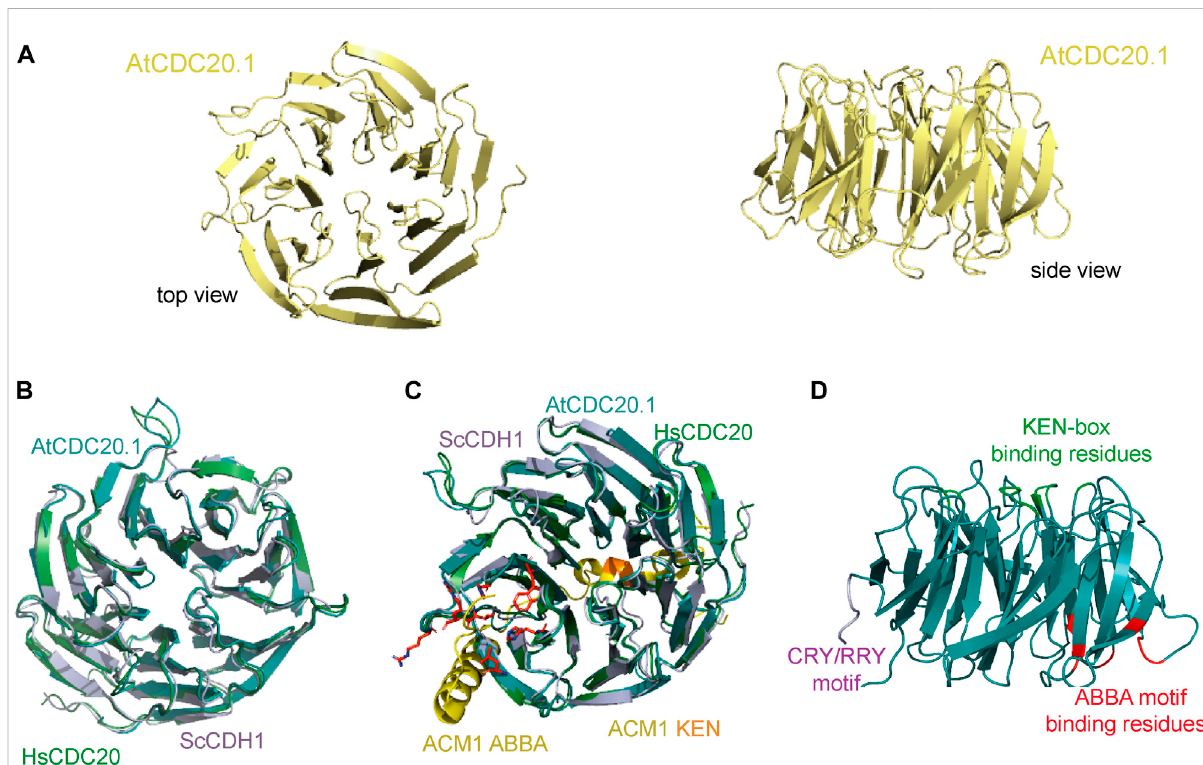
FIGURE 4 Predicted AtCDC20.1 WD40 3D structure. (A) Two views of the AtCDC20.1 3D structure model in a ribbon representation. The model was generated by comparative modelling using Phyre2 (Kelley et al., 2015). (B) Structure superposition of AtCDC20.1 WD40 structure model (cyan) with humanCDC20WD40(green,PDBID4GGC),andCDH1WD40frombuddingyeast(purple,PDBID4BH6)revealsahigh3Dstructureconservationof CDC20from various species andyeastCDH1. (C) Structure superpositionofCDH1incomplexwithan ACM1 fragment containingtheKEN-box and ABBA motifs (shown in yellow, PDB ID 4BH6) and CDC20 from human (shown in green, PDB ID 4GGC) and the A. thaliana 3D structure model showsthepredictedmodeofinteractionofAtCDC20.1withinteractionpartnersofthisproteinthatcontainthesemotifsandmediateSACsignalling. The AtCDC20.1 residues predicted to bind the ABBA motif are shown in red in stick and ball representation, while those predicted to bind the KEN- box are highlight in orange. (D) . Cartoon illustrating the mapping of the CRY/RRY motif (shown in purple) and a simpli fi ed view of the regions containing the residues that are implicated in binding the KEN-box (green) and ABBA motif (red) of CDC20 interaction partners. The binding of AtCDC20.1 to the latter SLiMs is anticipated to be critical for the proper segregation of chromosomes upon cell division in A. thaliana